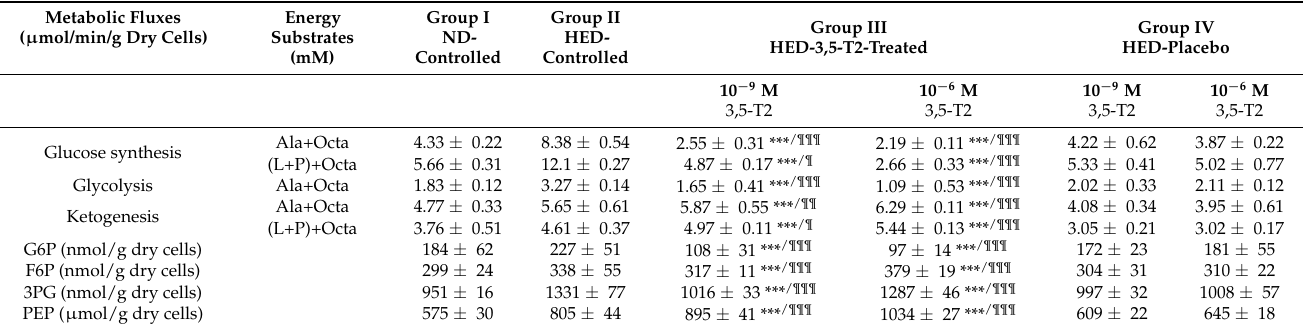
Figure 2. Effects of 3,5-T2 on oxygen consumption in isolated hepatocytes from experimental P. obesus fed ND or HED. ND: Natural Diet, HED: High Energy Diet. Freshly isolated hepato- cytes from 16 h-fasted P. obesus were incubated in Krebs/bicarbonate, buffer containing alanine or lactate (L) + pyruvate (P) together with octanoate ( A , B ) in the absence or presence of 3,5-T2 (10 − 9 or 10 − 6 M). The oxygen consumption rate was determined polarographically at 37 ◦ C with a Clark elec- trode and expressed as natoms O 2 /min/mg protein. Data are expressed as mean ± SEM. *** p < 0.001 compared 3,5-T2-treated group versus HED placebo group. ¶ p < 0.05; ¶¶¶ p < 0.001 compared 3,5-T2-treated group versus ND placebo group. ns: no significant. Table 4. In vitro effects of 3,5-T2 on hepatic gluconeogenesis, glycolysis, ketogenesis and intracellular intermediary metabolites fluxes from experimental P. obesus